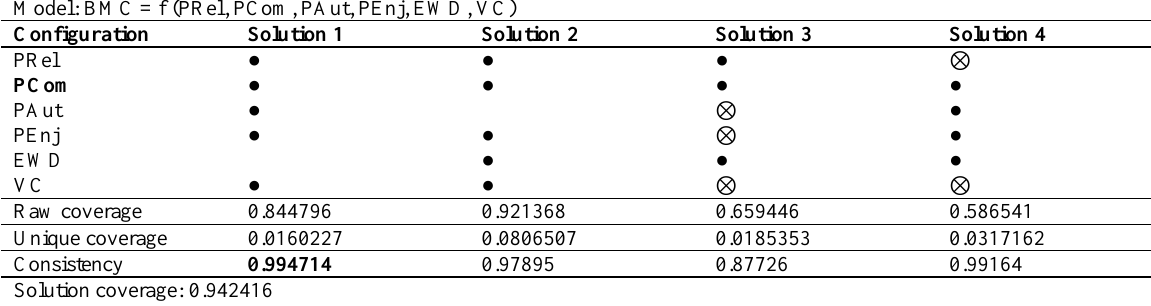
Table 8 : fsQCA analysis (intermediate